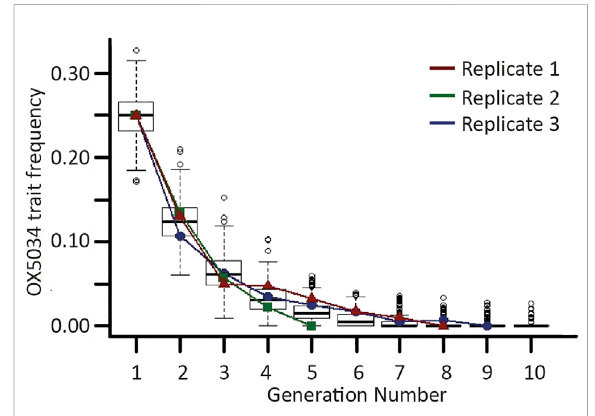
FIGURE 2 Trait decline of OX5034 Aedes aegypti . Boxplots showing the results from 500 iterations of a stochastic model simulating the extinction of a male-selecting genetic trait under restrictive conditions (off-doxycycline rearing). Horizontal bold lines represent generational medians; upper and lower box lines represent fi rst and third quartiles, respectively; outer horizontal lines represent 1.5× the interquartile range; and open circles represent data points over 1.5× above or below the fi rst and third quartiles.Overlaidontotheboxplotsarelines(red,blueandgreen) showing male-selecting trait frequency changes from three replicates of caged experiments. Generation 1 represents a post- fi eld release population with a trait frequency of